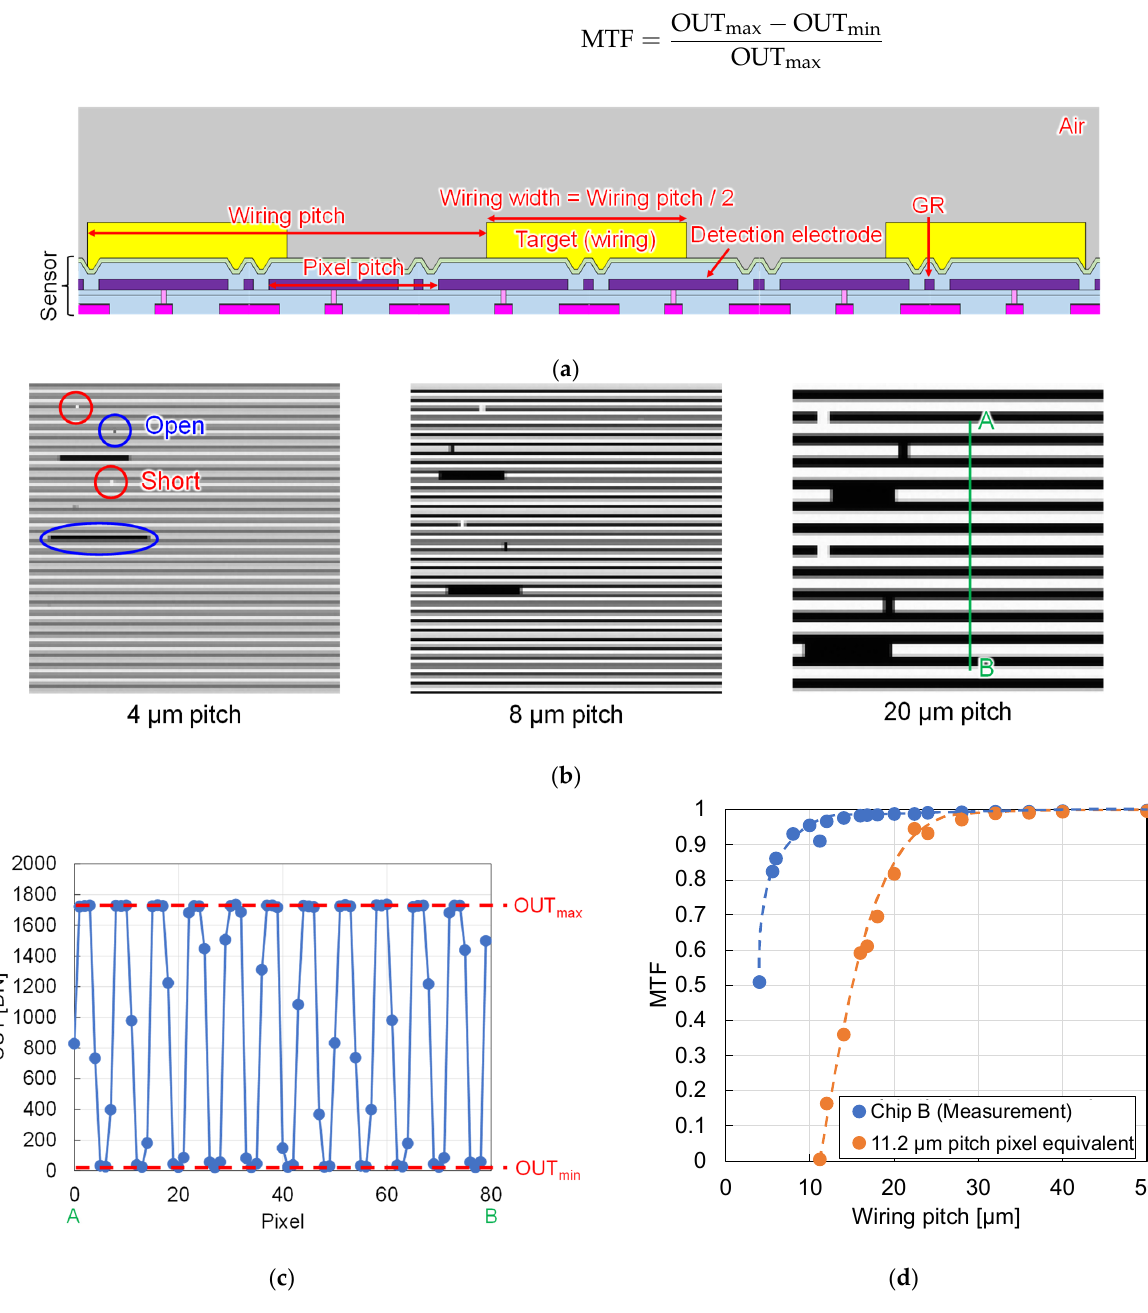
Figure 13. Resolution measurement of Chip B: ( a ) cross-sectional structure of the chip with metal wiring created on the surface; ( b ) captured images of the wiring for each pitch; ( c ) output signal for each pixel when 20 μm pitch wiring captured by Chip B; ( d ) MTF calculated from the measurement results.